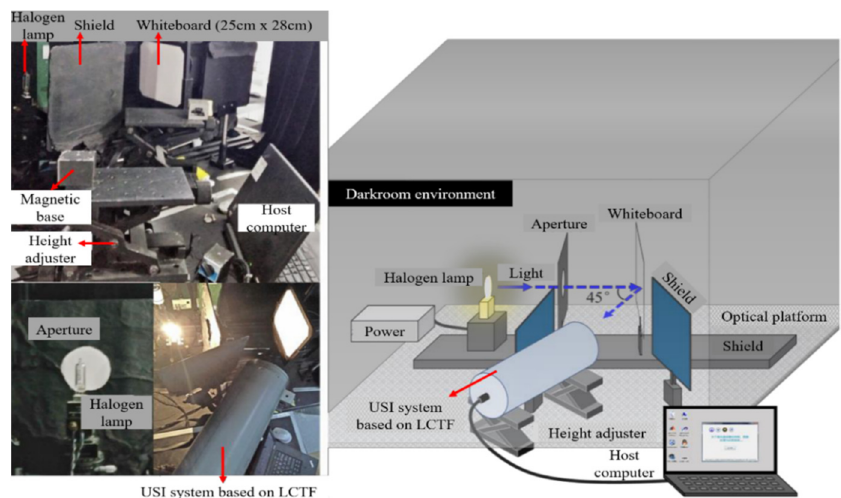
Figure 6. Schematics of the experimental setup for spectral radiometric calibration of the designed USI system.